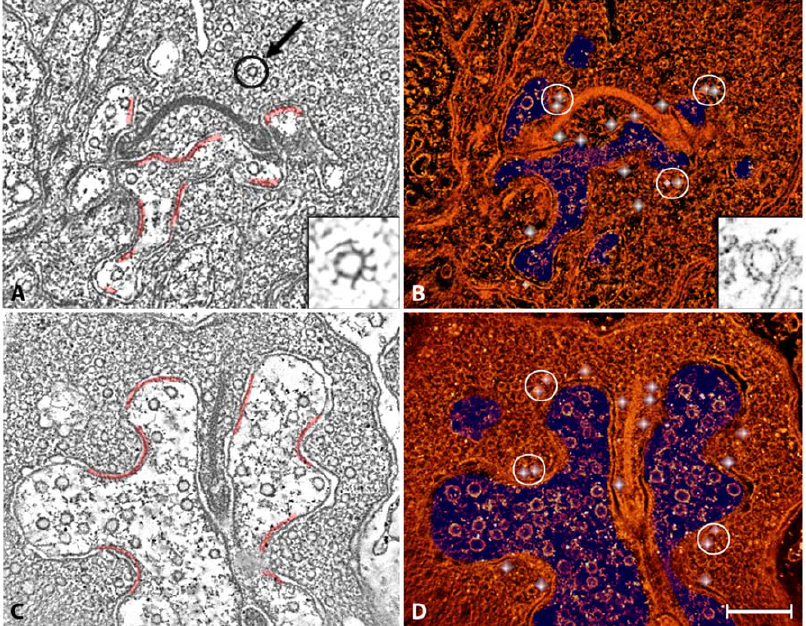
(blue regions). Bar=0.20 m m.